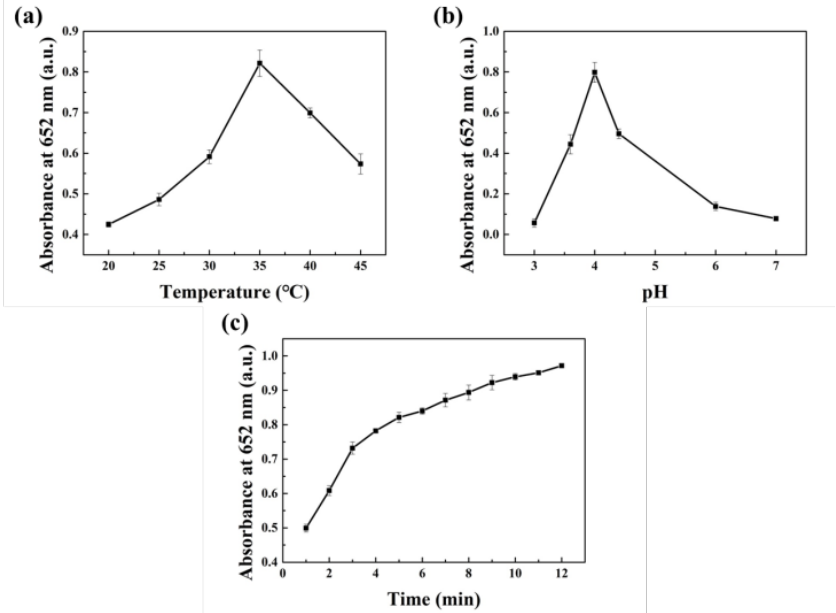
Figure 4. E ff ects of di ff erent conditions on the oxidase-like activity of Pt NPs: ( a ) Temperature, ( b ) pH, ( c ) time.